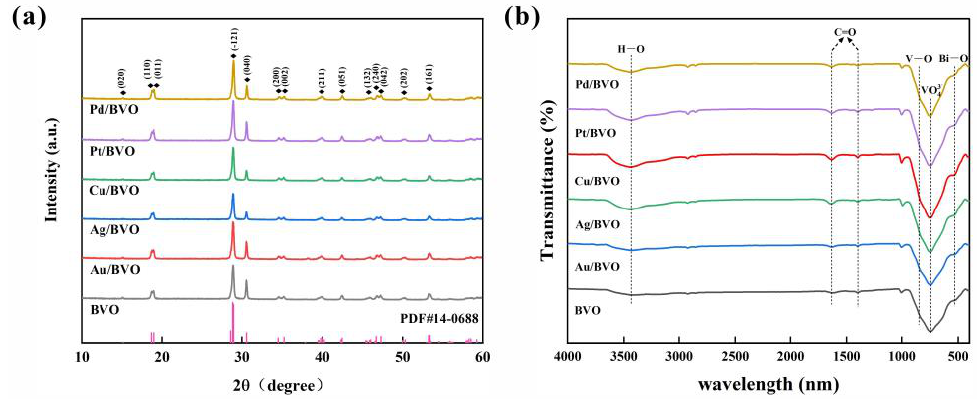
Figure 1. ( a ) XRD patterns and ( b ) FTIR spectra of bare and modified BVO samples.